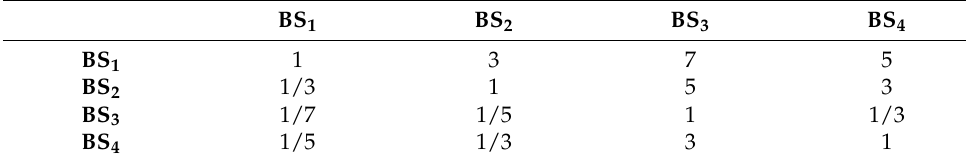
Table A3. The pairwise comparison matrix C 3 .